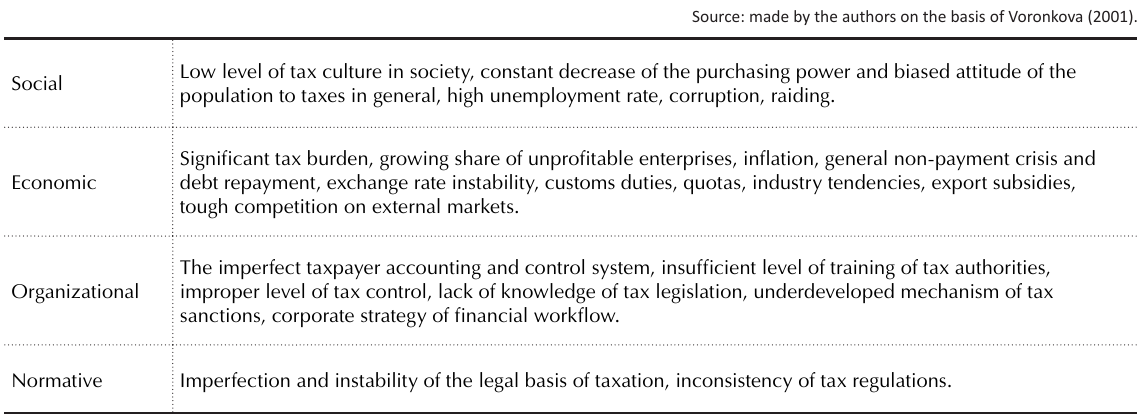
Table 2. The main reasons for the development of transfer pricing in Ukraine